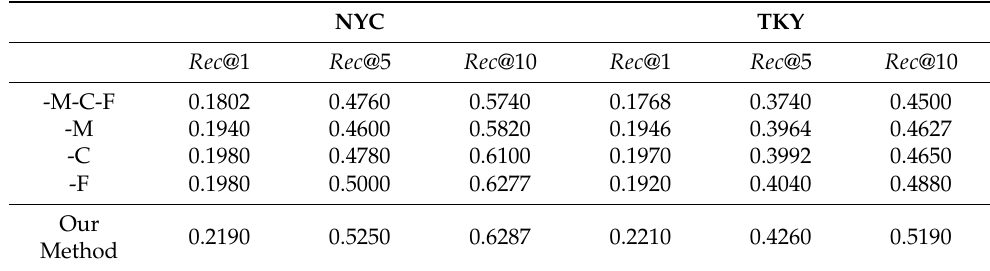
Table 3. Results of ablation experiments.